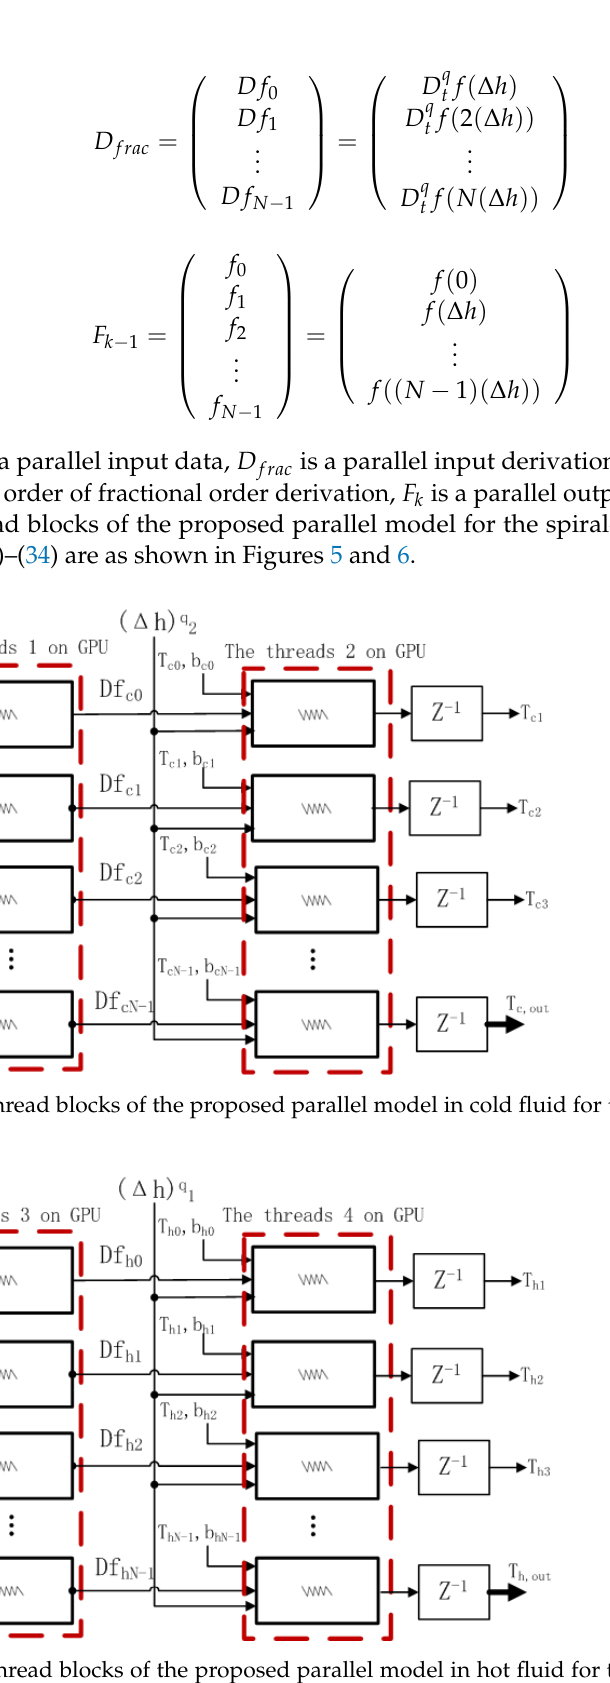
Figure 6. The thread blocks of the proposed parallel model in hot fluid for the counter-flow heat